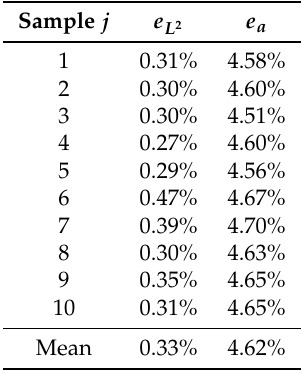
Table 4. Percentage error of multiscale solution u ms in experiment 1.